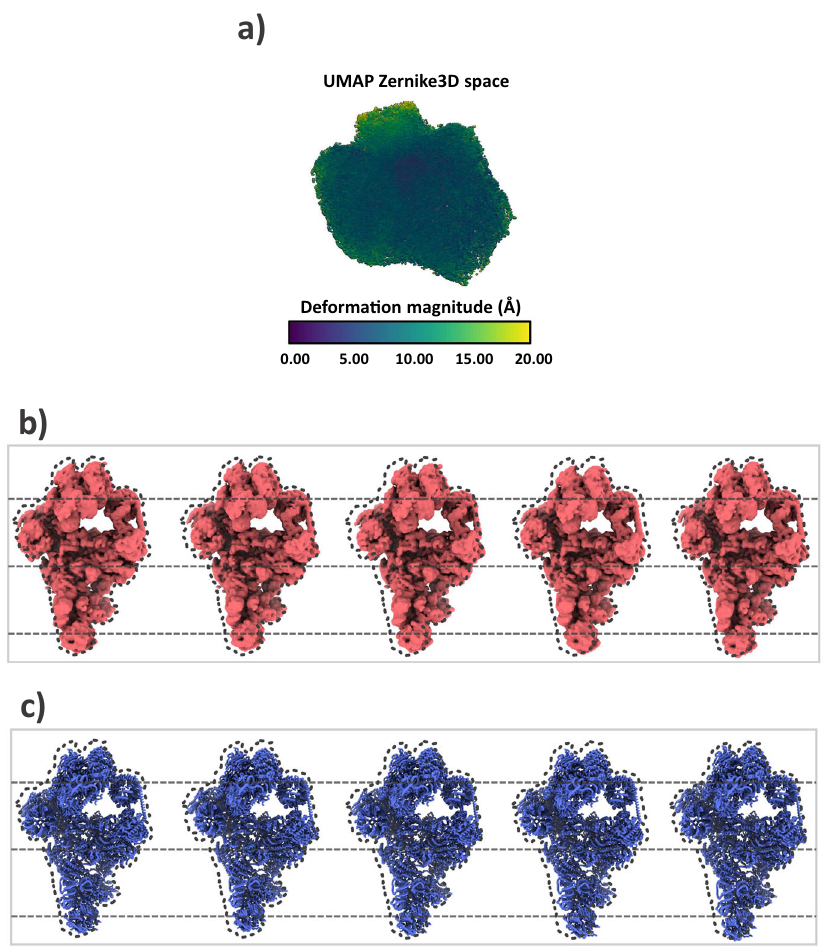
Fig. 4 | Analysis of the EMPIAR-10180 Zernike3D conformational landscape. a UMAP representation of the Zernike3D coef fi cient space obtained from the estimation of the per-particle conformational changes associated with EMPIAR- 10180. The color map represents the deformation fi eld magnitude associated with each particle involved in the analysis. b Example of fi ve conformations extracted from the landscape shown in a after clustering by KMeans. The different con- formations correspond to the representatives of each KMean cluster. The dotted graylinesareprovidedtoenhancethevisualizationoftheconformationalchanges.